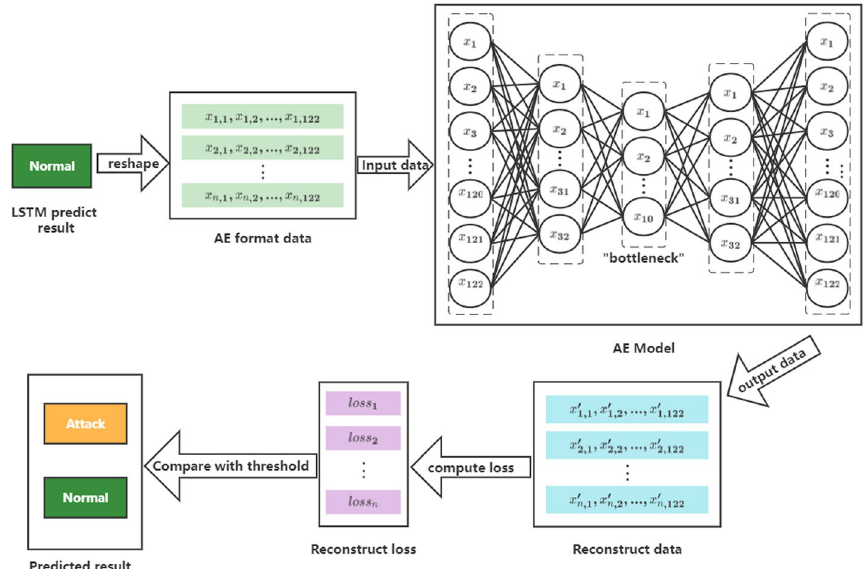
Fig. 7 The designed AE sub‑model data processing